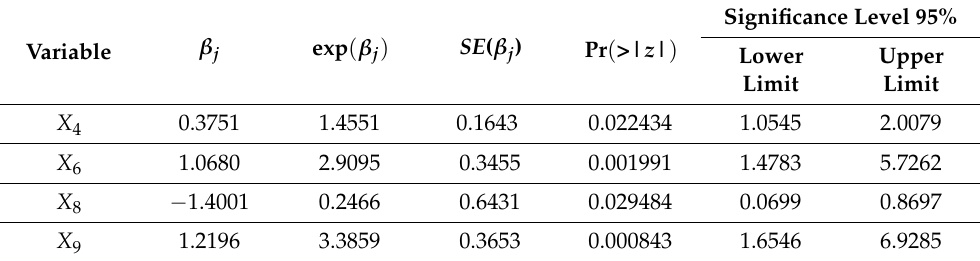
Table 12. Parameter estimation of the best Cox proportional hazard